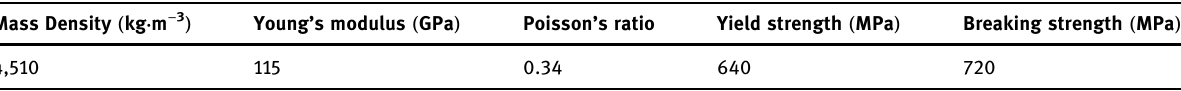
Table 2: The mechanical property parameters of Ti – 3Al – 2Mo – 2Zr alloy [ 19,20 ] Mass Density ( kg · m − 3